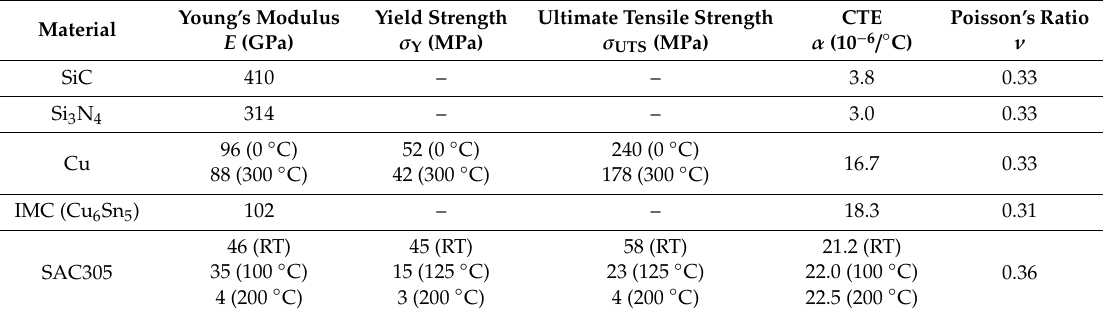
Table 2. Summary of selected physical properties used in this study; data is from [36–41].